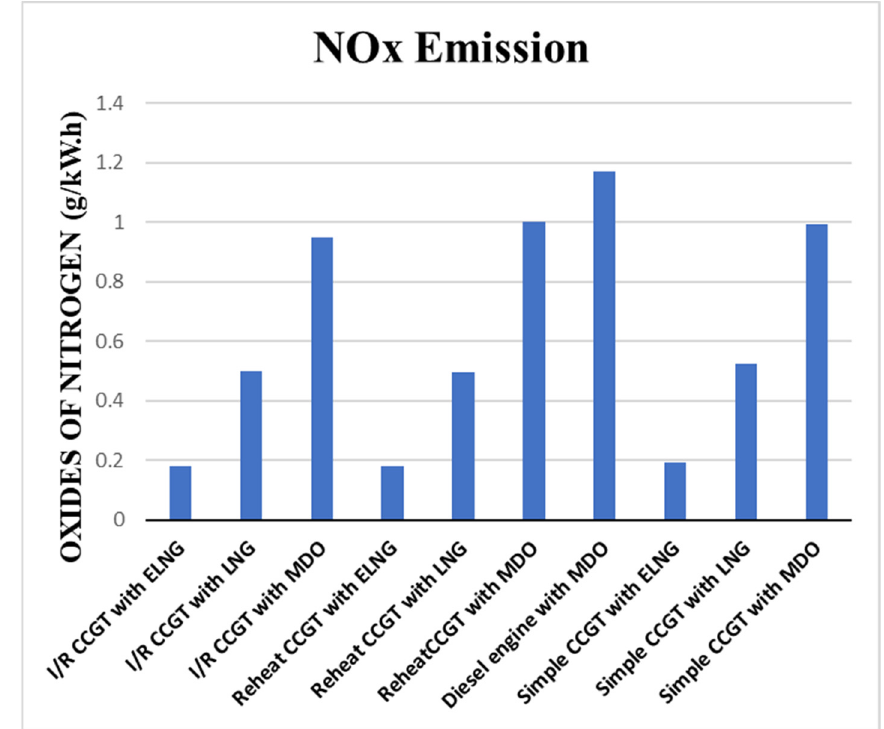
Figure 14 . NOx emissions from all propulsion systems.